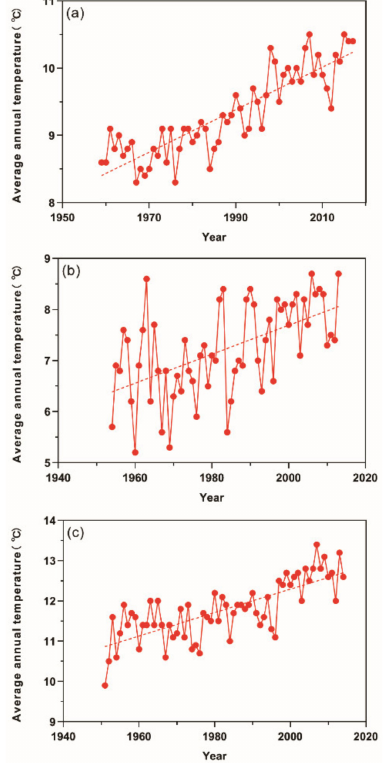
Figure 1. The change of annual average temperature (AAT) in China, as well as Xinjiang in recent decades. The dot represents AAT in a specific year and the dashed line shows the trend of temperature change. ( a ) China as a whole; ( b ) northern Xinjiang; ( c ) southern